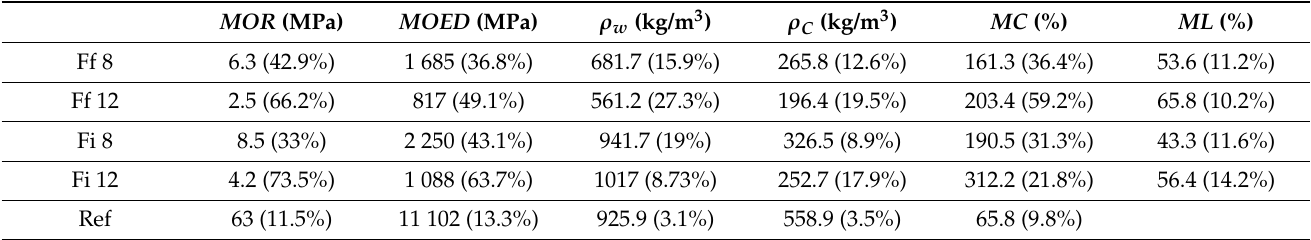
Table 2. Summary of average values for physical and mechanical properties with their coefficients of variation for both species at each exposure period and reference intact specimens.